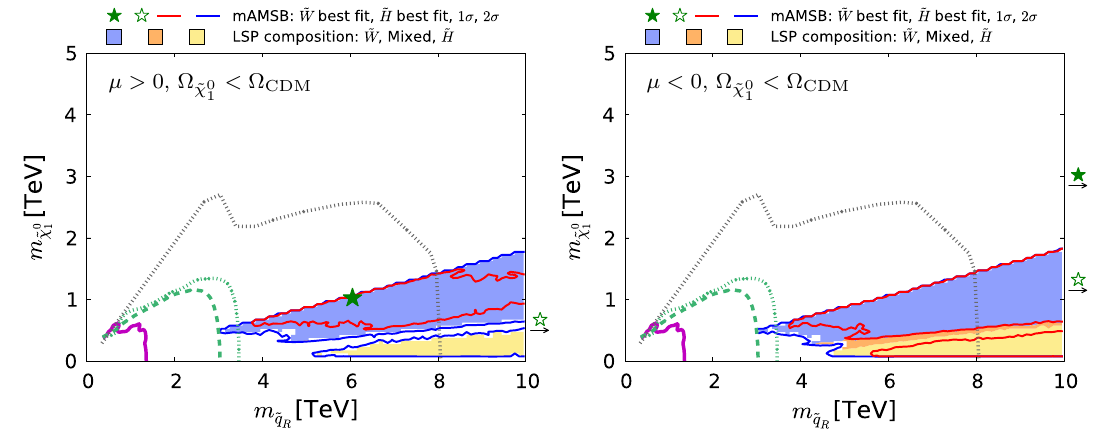
, m ) plane allowed in the (cid:4) ≤ line is the 95% CL sensitivity expected at a 100 TeV pp collider with Fig. 22 The region of the ( m ˜ q ˜ χ 0 ˜ χ 0 R 1 1 μ > 0 ( left ) and μ < 0 ( right ). The purple solid line (cid:4) a 3000 f b − 1 integrated luminosity obtained from [142]. All contours CDM case for assume a simplified model with 100% BR for ˜ q → q ˜ χ 0 represents the ATLAS 13-TeV 95% CL exclusion using 13 f b − 1 of limit and 100 TeV projection assumes decoupled gluino, while the pro- data [139]. The green dashed and dotted lines show the projected 95% jection to the higher luminosity LHC assumes a 4.5-TeV gluino. The CL sensitivity estimated by ATLAS [141] for 14-TeV data with inte- shadings are the same as in Fig. gratedluminositiesof300and3000 f b − 1 ,respectively.The greydotted